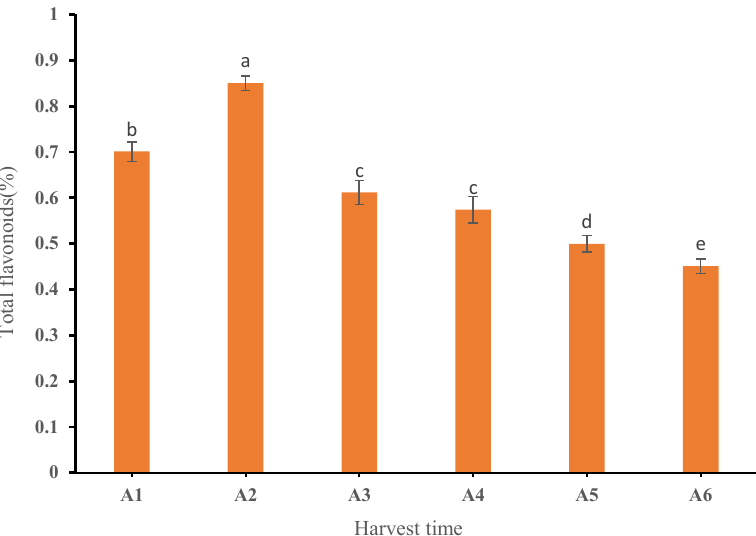
Figure 2. Change in total flavone content of dried PCR at different harvest periods. Different letters above each column indicate significant differences between the total flavone content of each month. The same letter above each column indicates no significant difference between the total flavone content of these